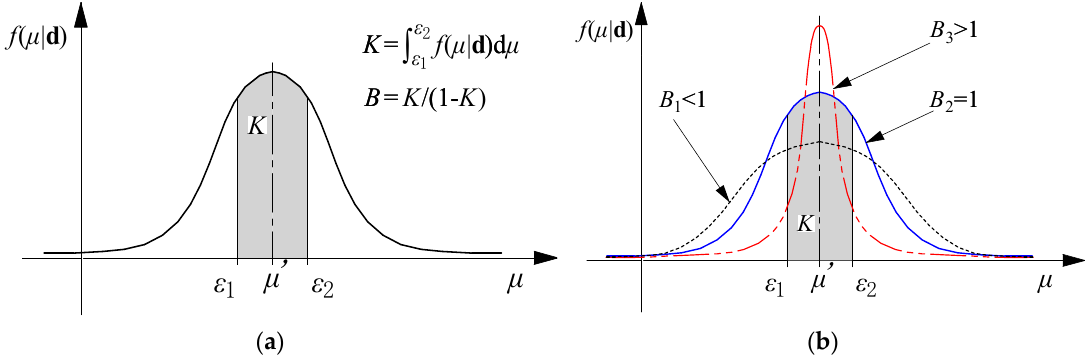
Figure 1. Interval-based Bayes factor. ( a ) Geometric meaning of Bayes factor; ( b ) Bayes factors B i of different probability density functions (PDFs).